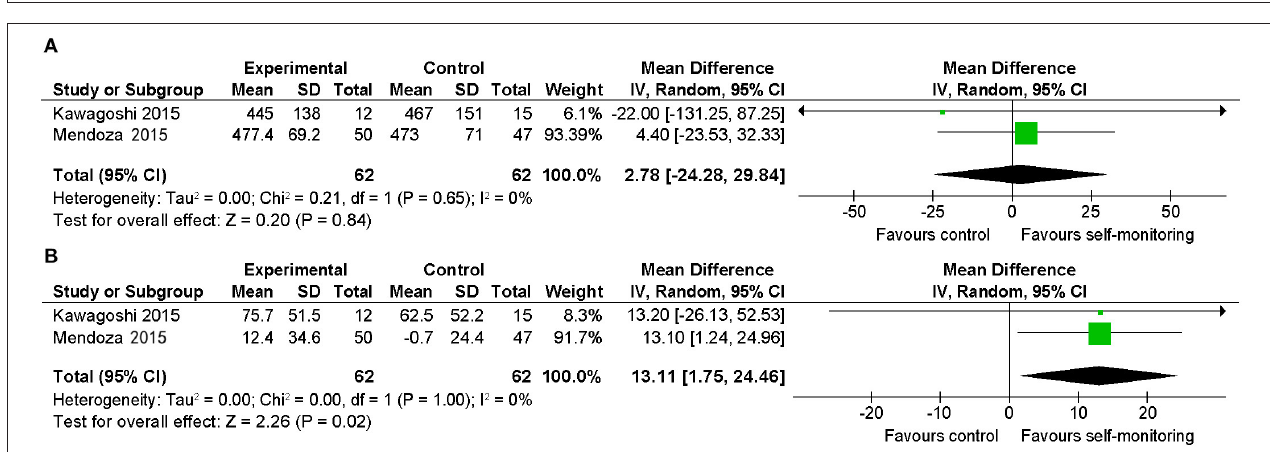
FIGURE 5 | Comparison of walking ability in patients with stable COPD. (A) Walking endurance (6-min walking distance, m) post-intervention. (B) Walking endurance (6-min walking distance, m) change from baseline. SD, standard deviation; IV, inverse variance method; CI, confidence interval.